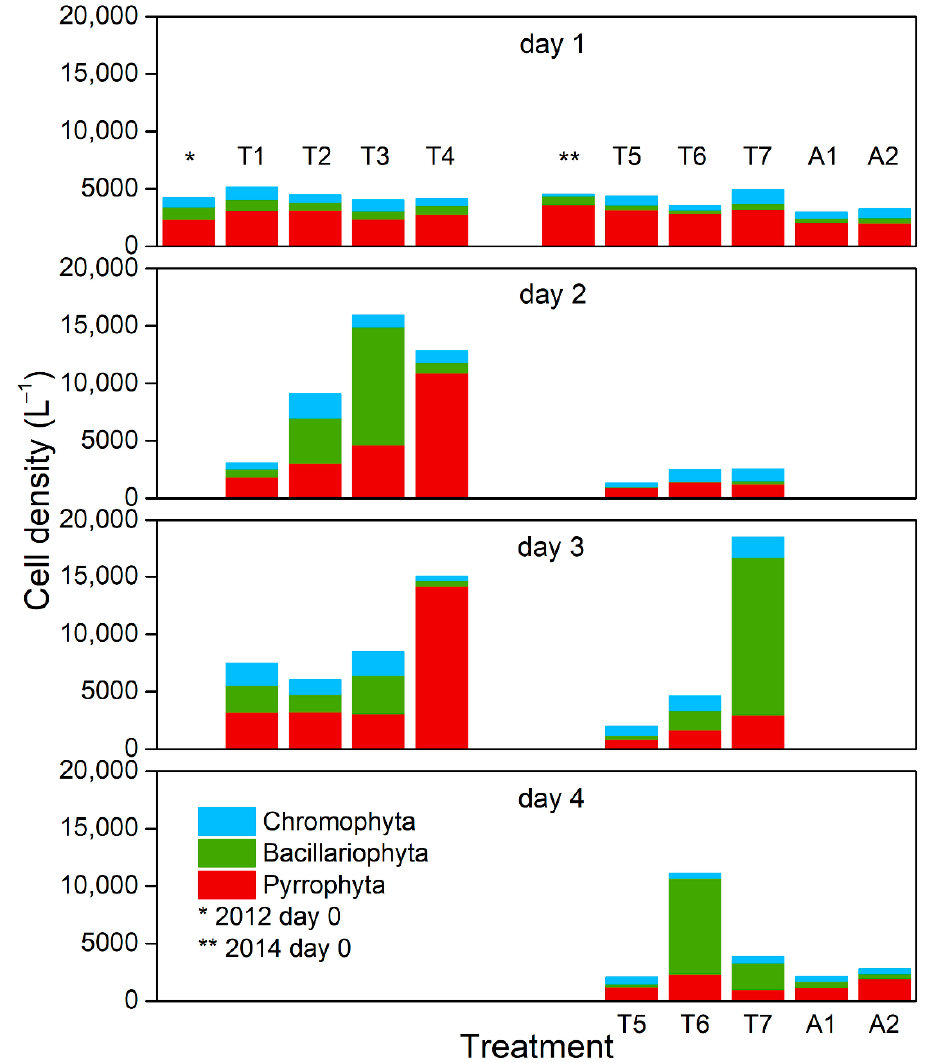
Figure 7. Change of phytoplankton community structure during the 2012 and 2014 bioassay experiments. Algal species belonging to three major phyla of Bacillariophyta, Dinophyta, and Chromophyta were identified.